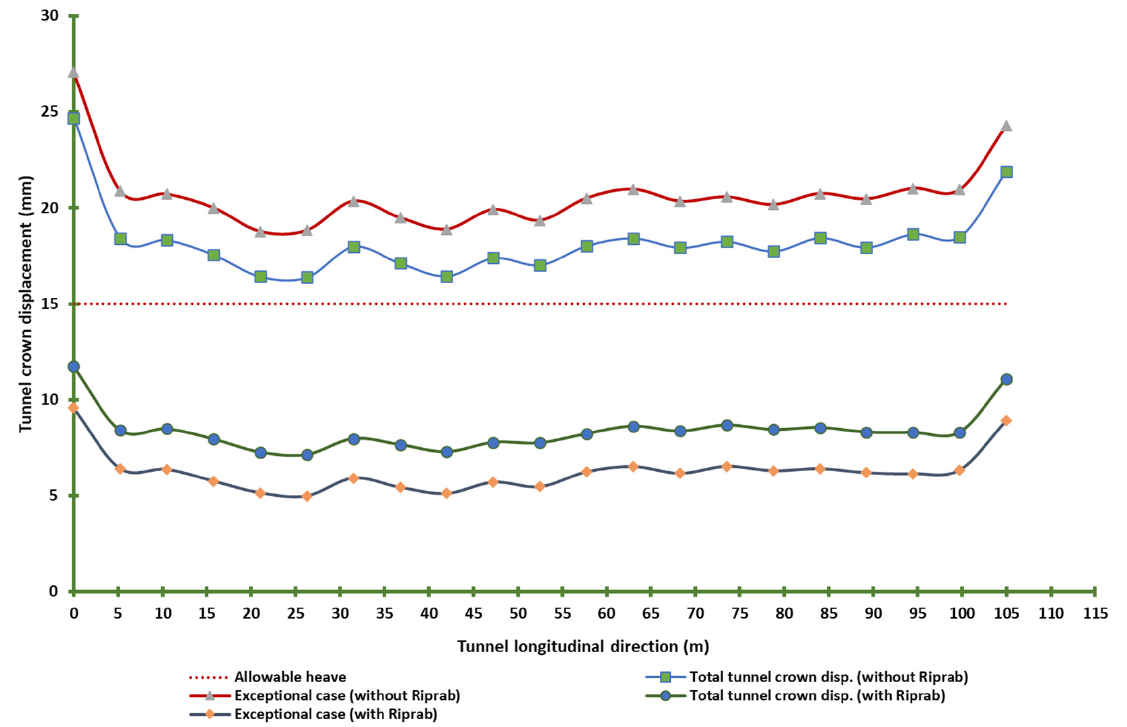
Figure 17. Displacement of tunnel crown during service.